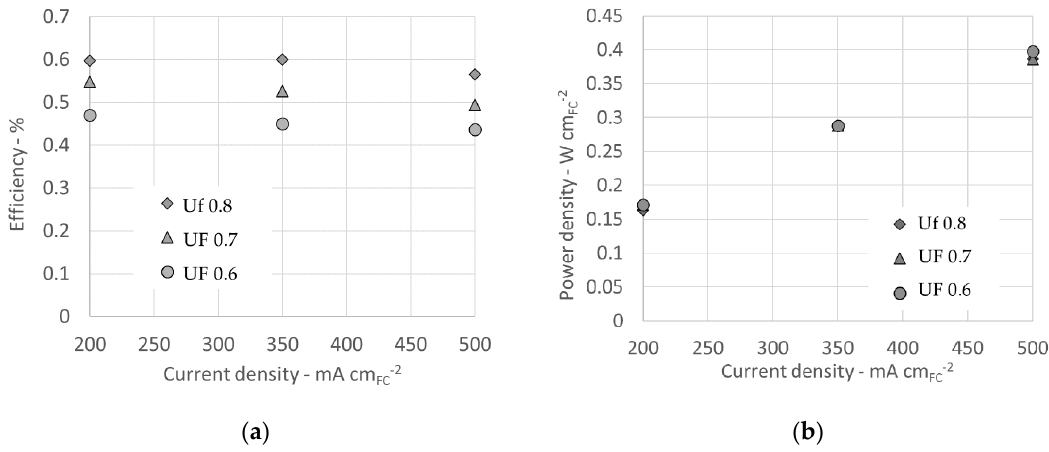
Figure 6. Stack efficiency ( a ) and power density ( b ) for pure ammonia (XNH3 = 0) and temperature ◦ 750 °C. 750